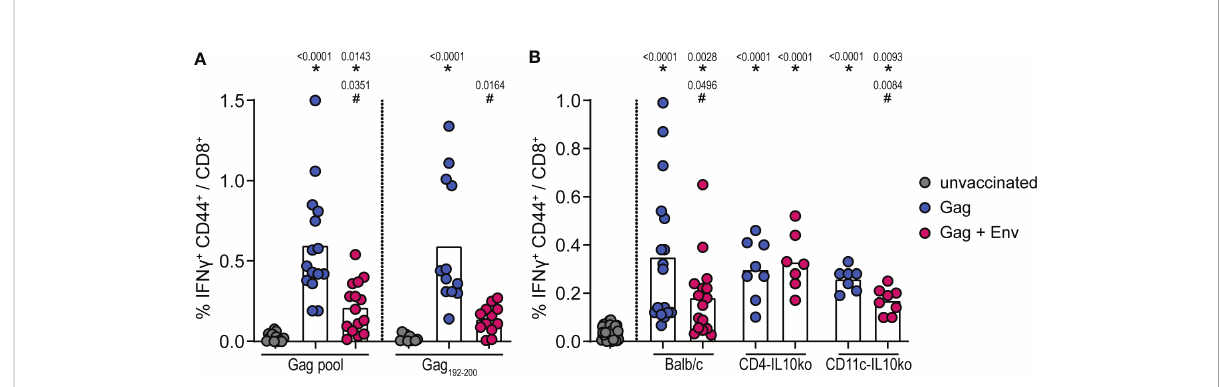
FIGURE 2 Suppression of HIV Gag-speci fi c CD8 + T-cell responses by F-MuLV Env. CB6F1 (A) and BALB/c, CD4-IL-10ko, and CD11c-IL-10ko mice (B) were immunized once with 25 µg of the plasmid pGag-eGFP encoding HIV Gag, or they were co-immunized once with pGag-eGFP and the plasmid pCG.env encoding F-MuLV Env SU+TM (25 µg each) by intramuscular injection followed by in-vivo electroporation. Two weeks after the immunization, mice were sacri fi ced and spleens were isolated, and the frequency of Gag-speci fi c IFNy + CD44 + CD8 + cells was analyzed by fl ow cytometry after in-vitro restimulation as indicated (A) or with an HIV Gag peptide pool (B) . Data from 15 (A) and 8/7 (B) mice per group were acquired in three (A) or two (B) independent experiments. Each dot indicates an individual mouse, and bars indicate mean values. Statistically signi fi cant differences compared with the unvaccinated group are indicated by *, and differences compared with the HIV Gag group are indicated by # ( p < 0.05, Kruskal – Wallis one-way ANOVA on ranks, Dunn ’ s